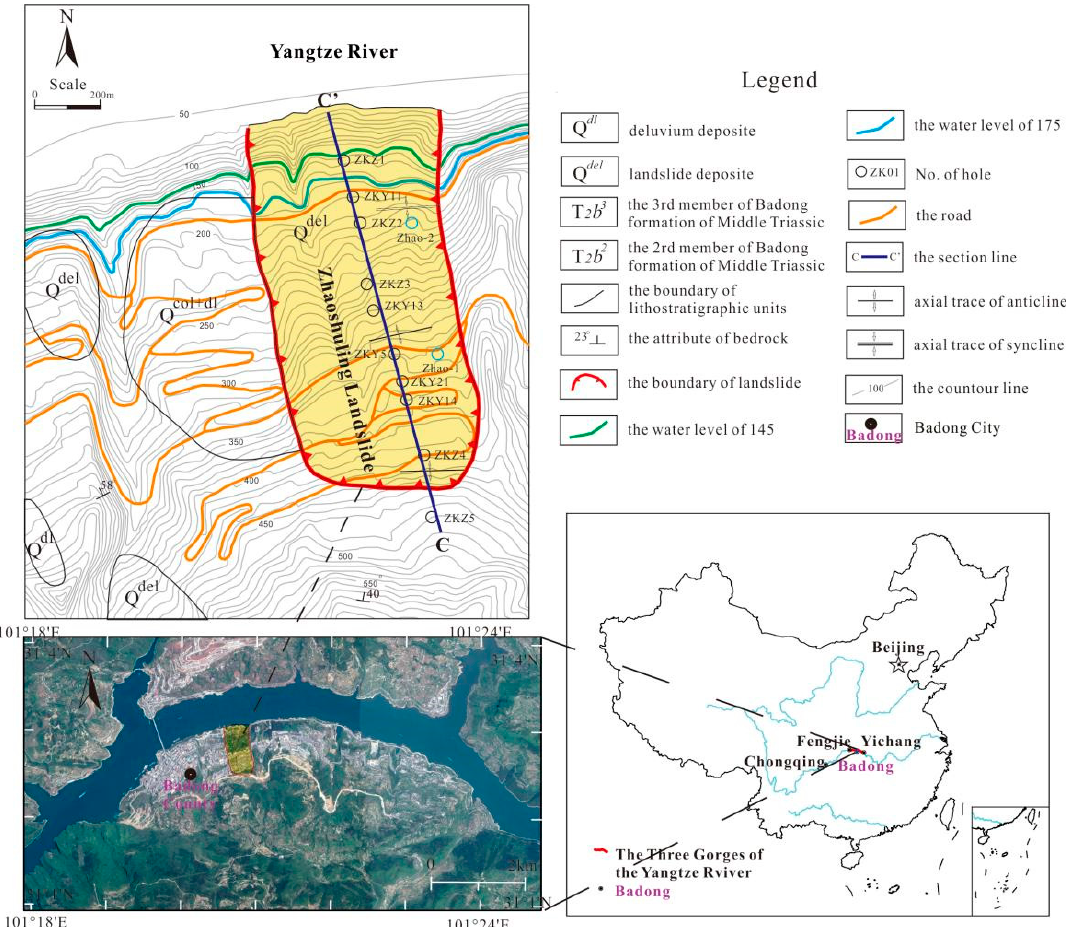
Figure 1. Engineering geological map of the Zhaoshuling Landslide.